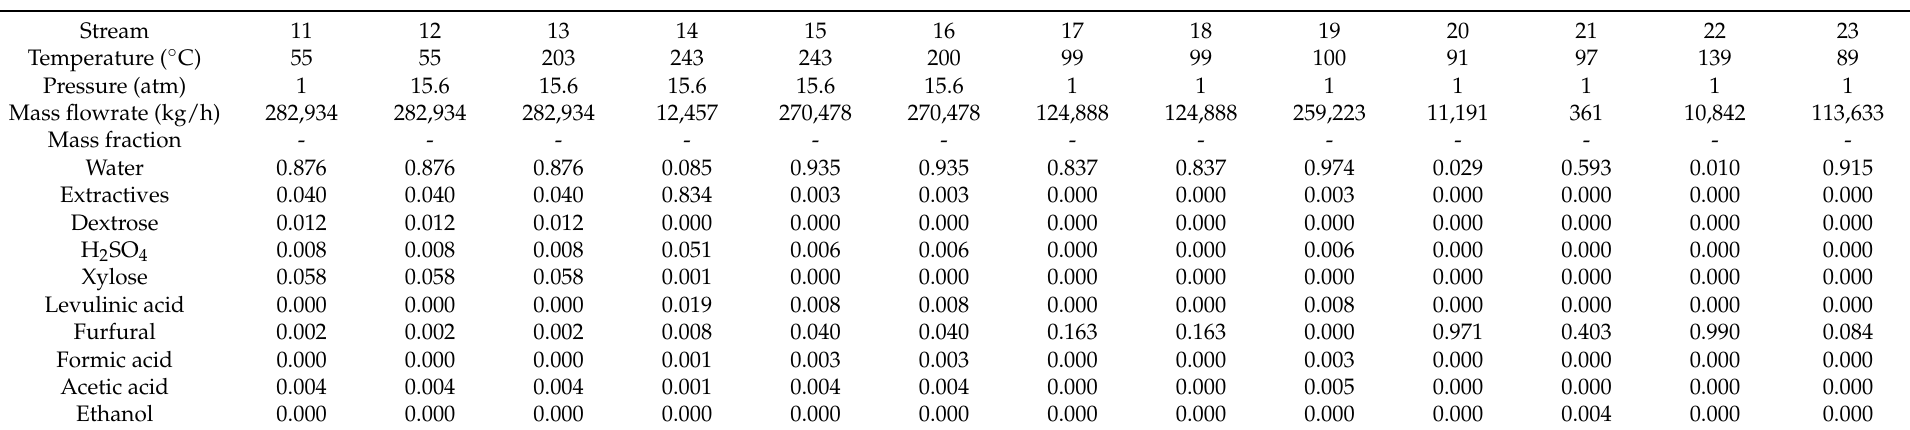
Table 1. Stream table of the reaction-distillation